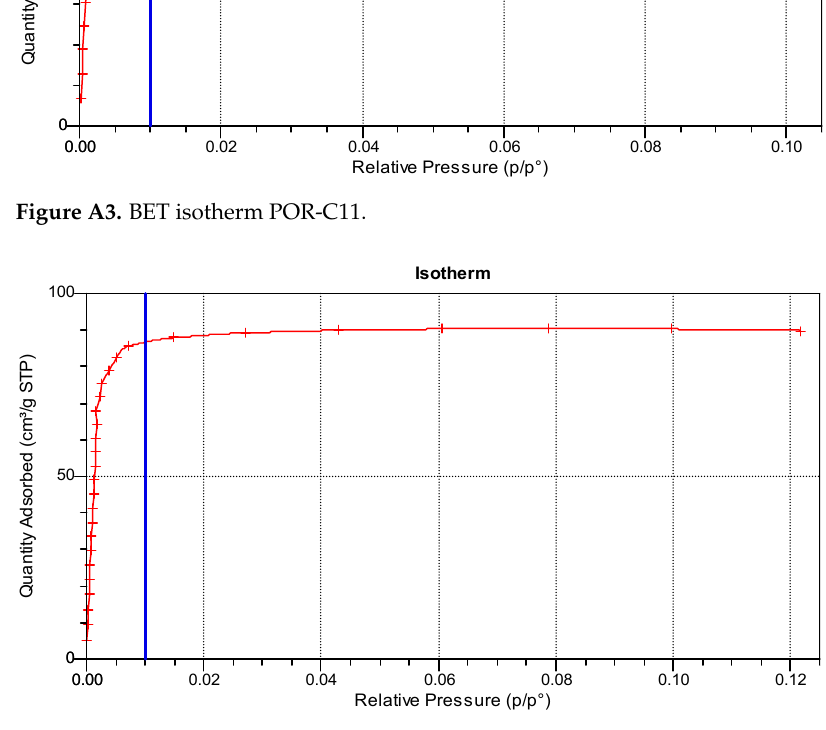
Energies 2022 , 15 , x FOR PEER REVIEW